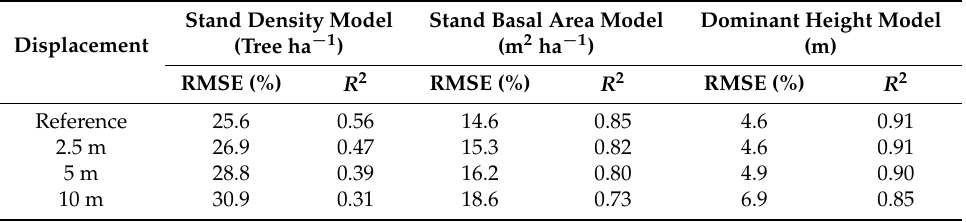
Table 2. Effect of plot positioning errors on the estimation of stand variables as described by root mean squared error (RMSE %) and adjusted R 2 , both computed on the original scale.